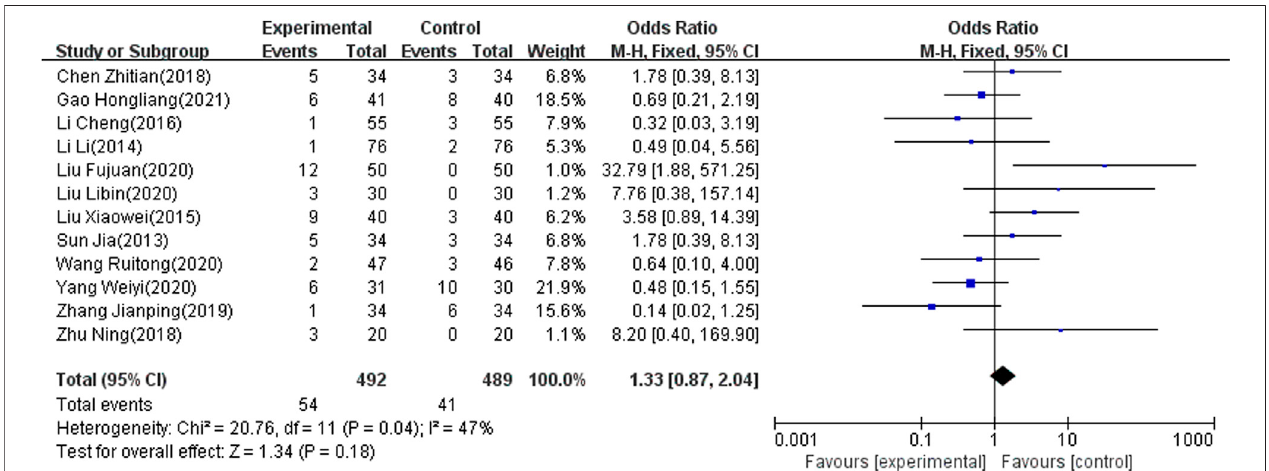
FIGURE 7 | Forest plot of side effect rate.